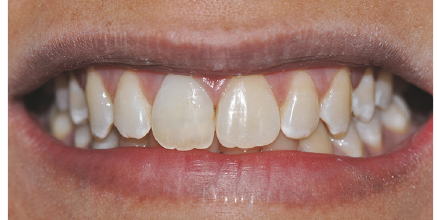
Figure 8: Clinical aspects after internal nonvital bleaching.